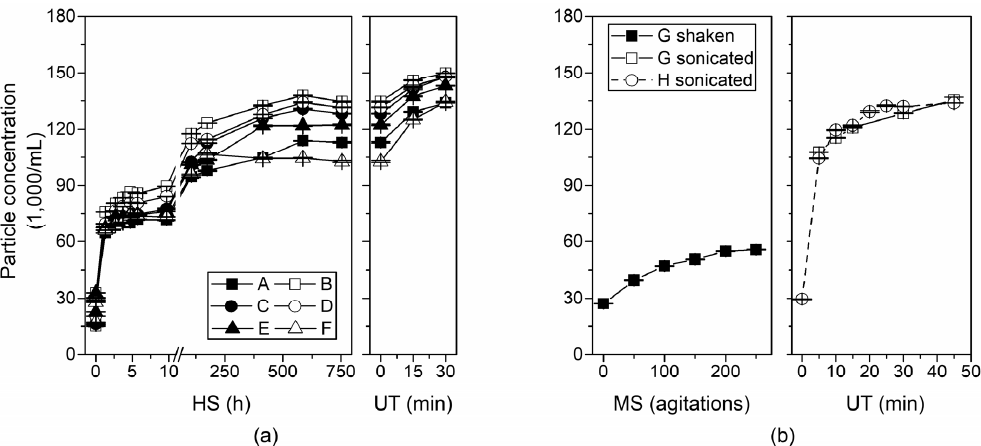
Figure 2: (a) Left: Particle concentration of six batches (20 mg/L PS particles) during 750 h horizontal shaking (HS). Right: Particle concentration of the same 6 batches during 30 min ultrasonic treatment (UT). (b) Particle concentrations of two batches (20 mg/L PS particles); batch G was manually shaken (MS) for 250 times (left diagram, full squares) and subsequently sonicated (right diagram, empty squares), batch H was directly sonicated (UT; right diagram, empty circles). Error bars show standard deviation of n = 3.